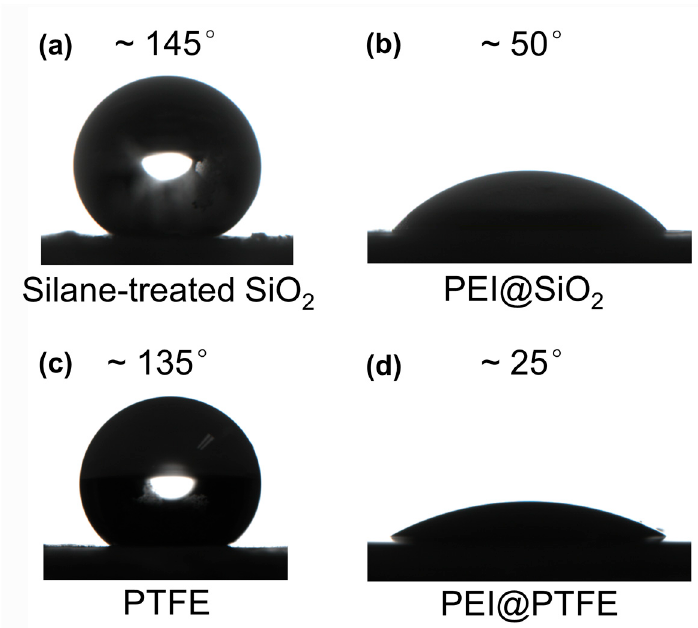
Figure 5. The water contact angles of ( a ) silane-treated SiO 2 HPs, ( b ) PEI@SiO 2 HPs, ( c ) PTFE HPs, and ( d ) PEI@PTFE HPs.